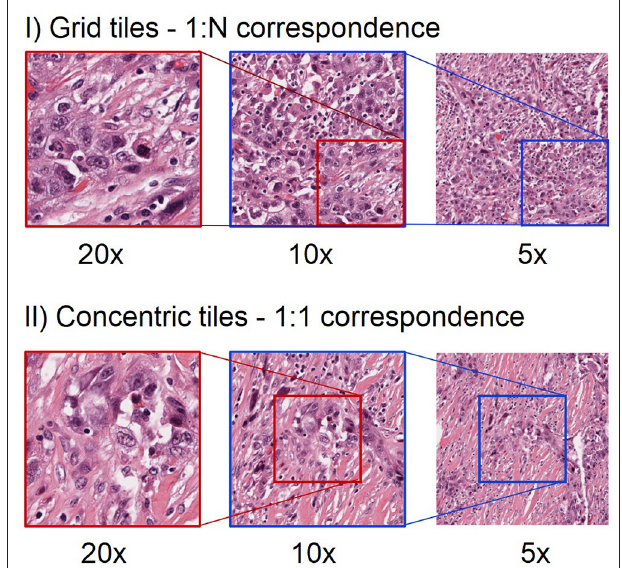
FIGURE 1 | Different approach to extract tiles at multiple magnification levels. The first row shows an example of grid multi-scale tiles. Each tile at 5x can be linked with 4 tiles at 10x and 16 tiles at 20x. Hence, there is a 1:N mapping between tiles from the highest magnification level to the next lower magnification level. Note that for clarity we only show one such tile in this illustration. The second row shows an example of concentric tiles. In this case, each tile at 20x is considered as the centroid for the tiles at lower magnification levels, resulting in a 1:1 correspondence between tiles at different magnifications. When using concentric tiles there will be large overlaps between tiles at lower magnification levels. When using grid tiles, there is no such